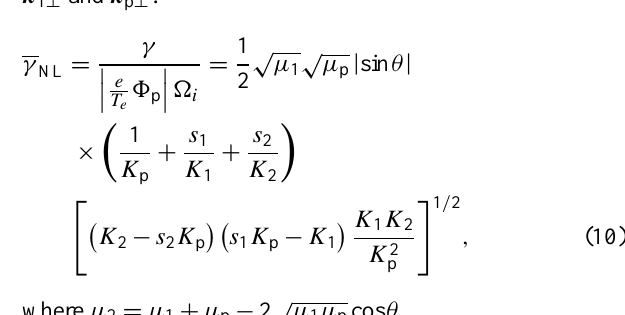
Figure 1. The normalized growth rate γ/ (cid:0) (cid:127) i µ p = 0 . 05. The left panel shows the forward decay and the right panel shows the reverse decay.